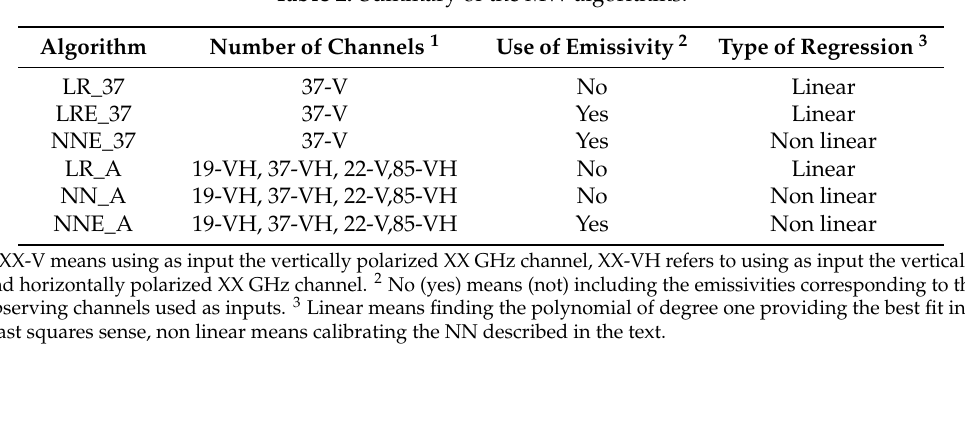
Table 2. Summary of the MW